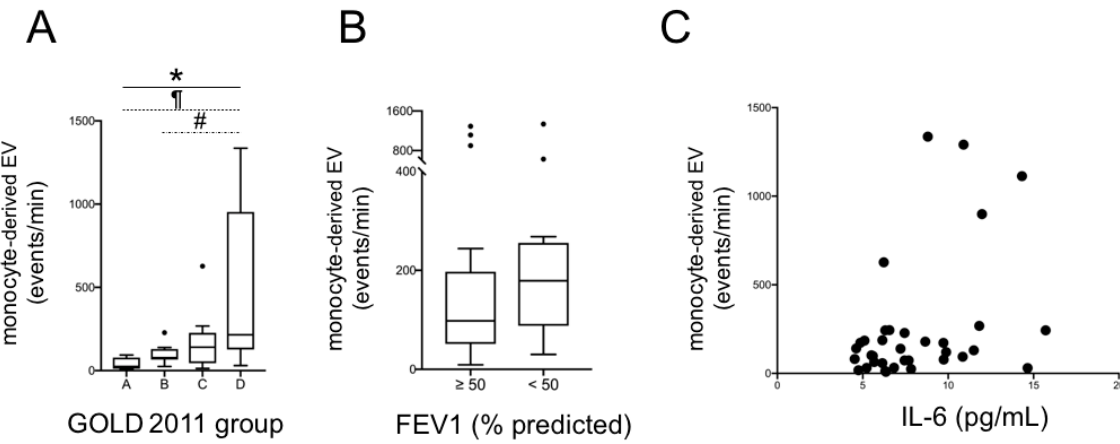
Figure 2. Total MEV according to 2011 GOLD group ( A ) and to FEV1 ( B ) (*: p < 0.001 for trend; ¶ and #: p < 0.05 for group D versus group A and B, respectively; Jonckheere–Terpstra test). Correlation between total MEV and plasma IL ‐ 6 ( C ). MEV: monocyte ‐ derived extracellular vesicles; FEV1: Forced Expiratory Volume in the 1st second; IL ‐ 6: interleukin ‐ 6.